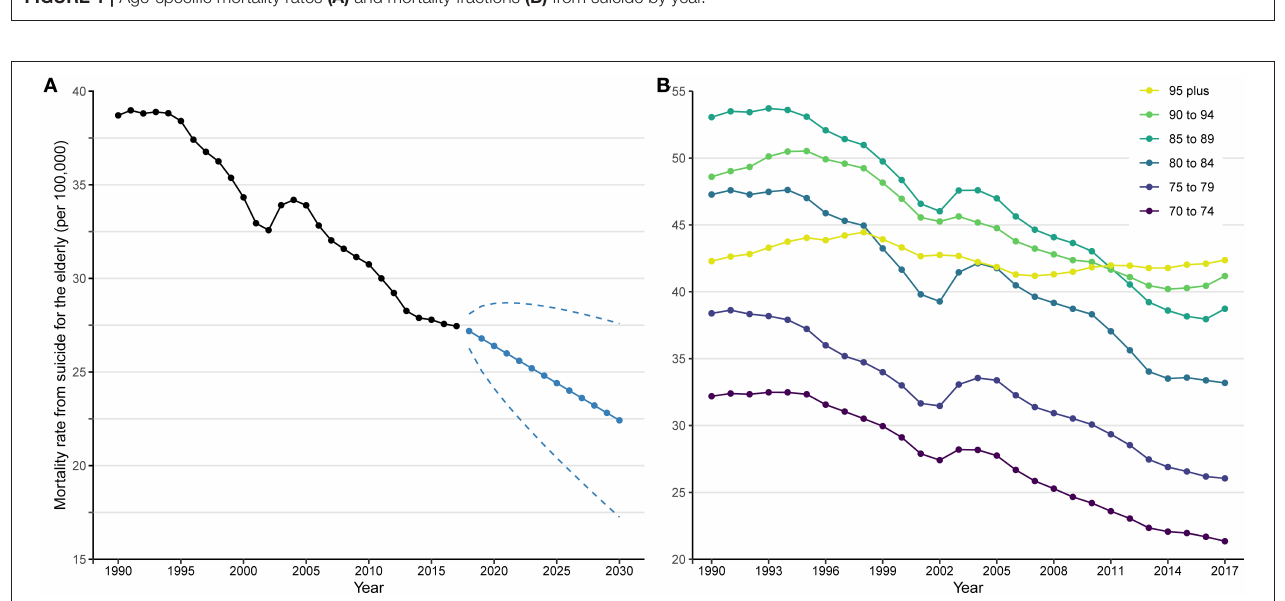
FIGURE 2 | Suicide mortality rates for the elderly from 1990 to 2017 and prediction up to 2030. (A) Trend and prediction of global mortality rate; (B) trends of mortality rates by age group. In (A) , black points and solid line denote suicide mortality rates for the elderly from 1990 to 2017 estimated by Global Burden of Disease study 2017. Blue points and solid line denote suicide mortality rates for the elderly from 2018 to 2030 projected by Autoregressive Integrated Moving Average model based on the mean rates from 1990 to 2017. Blue dashed lines denote 95% confidence intervals of the projected suicide mortality rates.